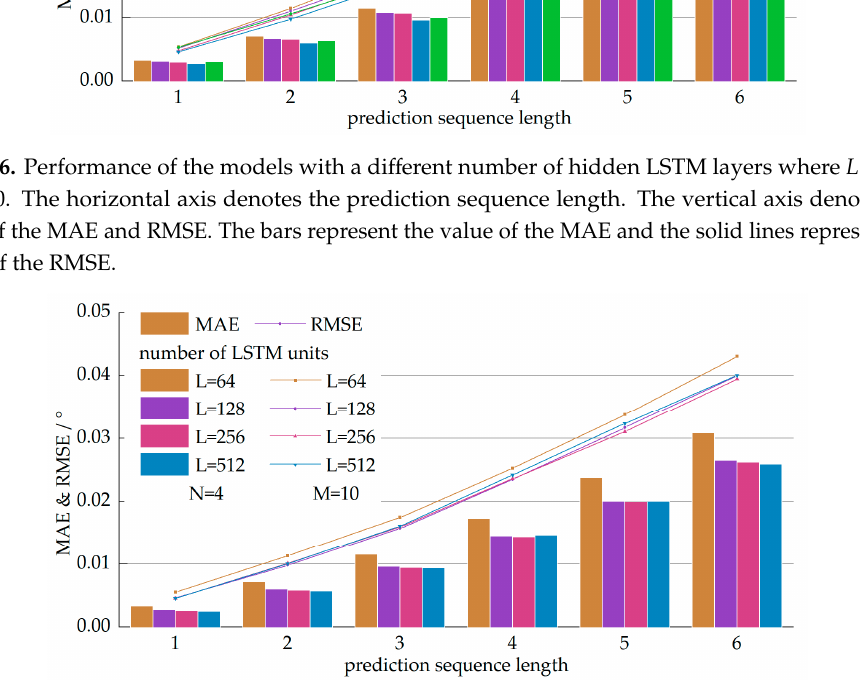
Figure 7. Performance of the models with a di ff erent number of LSTM units in each layer where N = 4, M = 10. The horizontal axis denotes the prediction sequence length. The vertical axis denotes the value of the MAE and RMSE. The bars represent the value of the MAE and the solid lines represent the value of the RMSE.